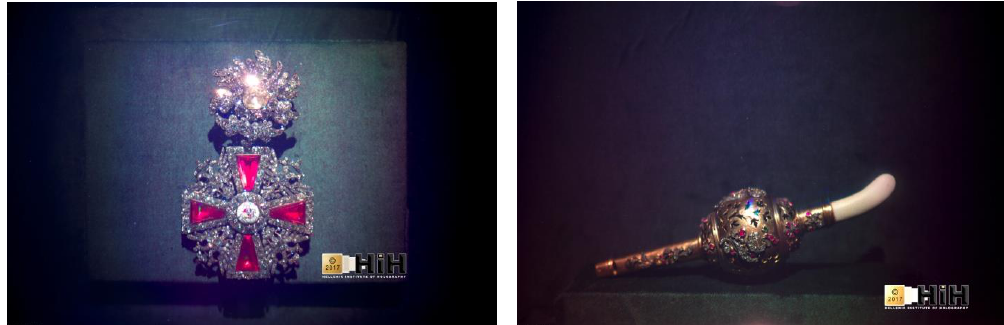
Figure 12. Photos of the recorded OptocClones TM of Order of St. Alexander Nevsky (left) and of the Imperial Whistle Cum Rattle (right) (Photos by A. V. Evdokimov, 2017. © 2017 HiH).